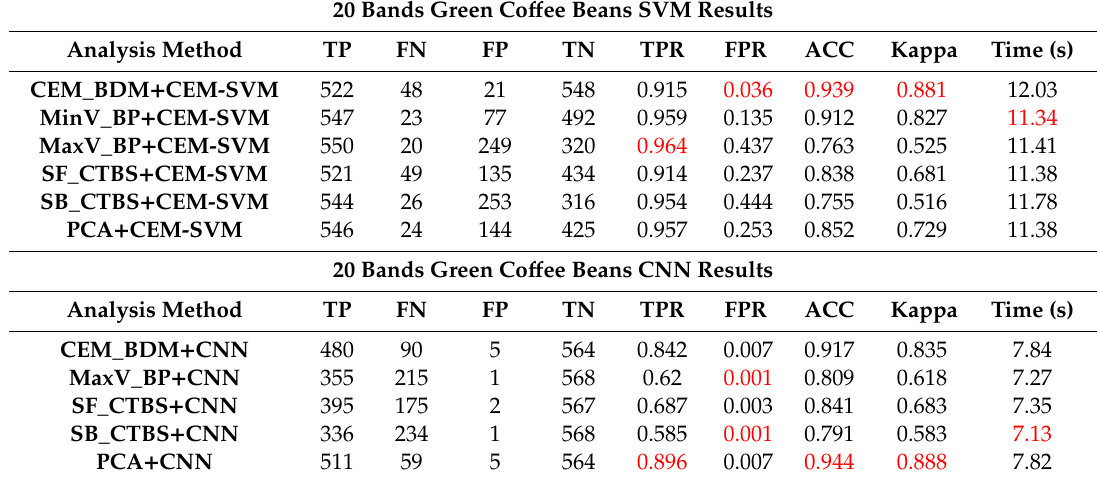
Figure 48. Results of green coffee bean CNN+PCA 20 bands. (a-d) CNN classification results, (e-h) final visual images.